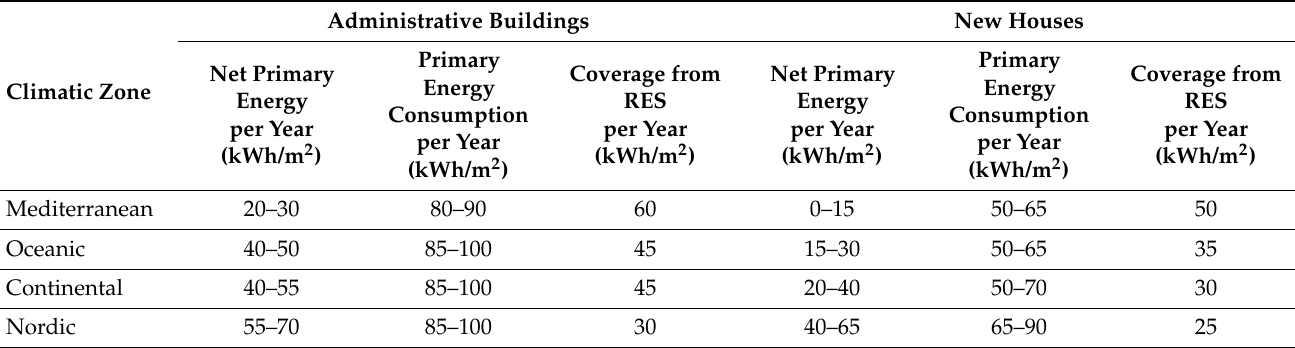
Table 1. Reference values for EPB with NZEB for different climatic zones in the EU (Commission Recommendation (EU) 2016/1318 of 29 July 2016 on guidelines to promote nearly zero energy buildings and best practices to ensure that all new buildings are nearly zero energy buildings by 2020).